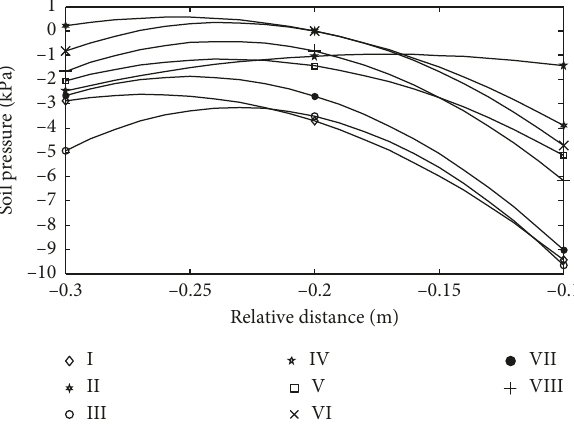
Figure 17: Fitting curve of soil pressure under the excavation.